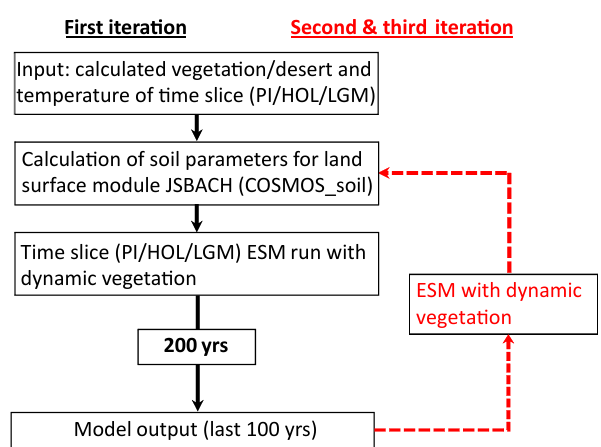
Figure 1. Flowchart of the asynchronous coupling procedure be- tween the earth system model (ESM) and the soil scheme (COS- MOS_soil). (PI: preindustrial period; HOL: